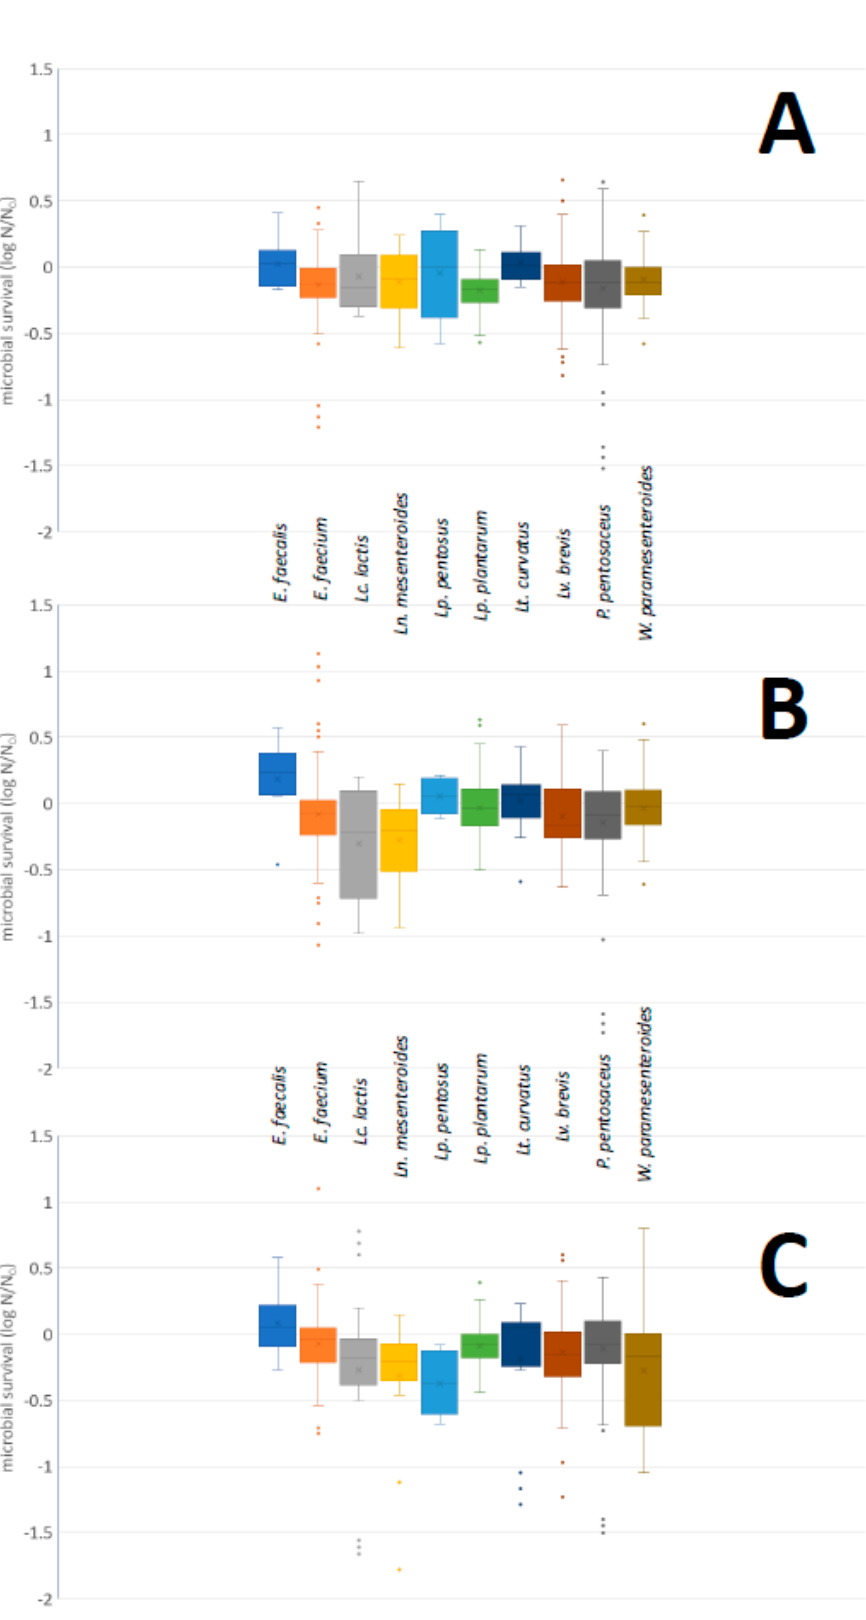
Figure 3. Box and whisker plot, summarizing the microbial survival (in log N/N 0 ) of the strains included in the present study, at species level after exposure to PBS buffer, pH 8, containing 0.5% ( A ), 1.0% ( B ), or 2.0% ( C ) ( w / v ) bile bovine and incubation at 37 ◦ C for 4 h. N: microbial population after incubation; N 0 : initial microbial population; solid circle symbol: